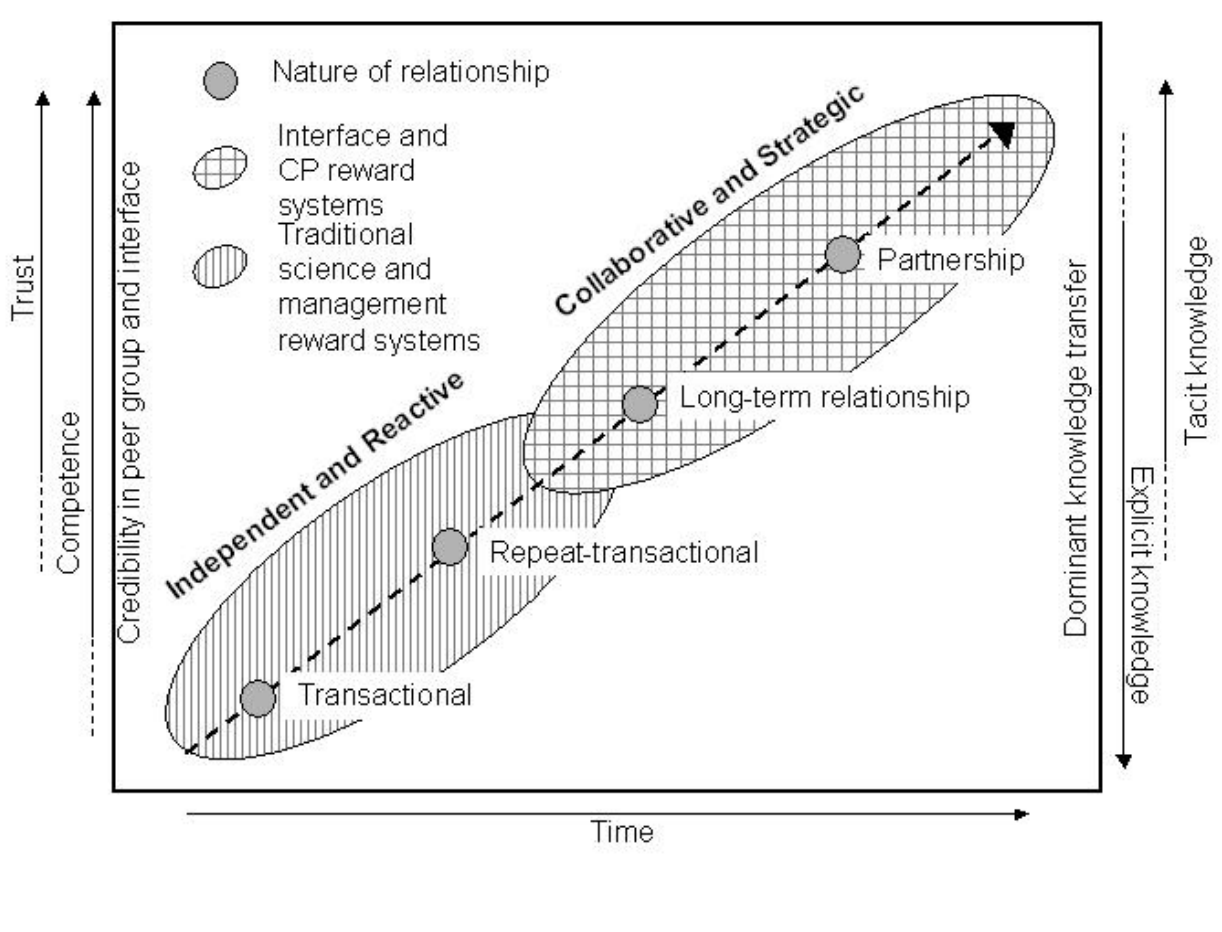
Fig. 5. The formation of a strategic alliance between science and management requires time for the development of trust (safety credibility), and would benefit from a reward system that acknowledges the need for tangible outputs such as papers, reports, and policies, as well as intangible outcomes such as new relationships, changed perceptions, and improved